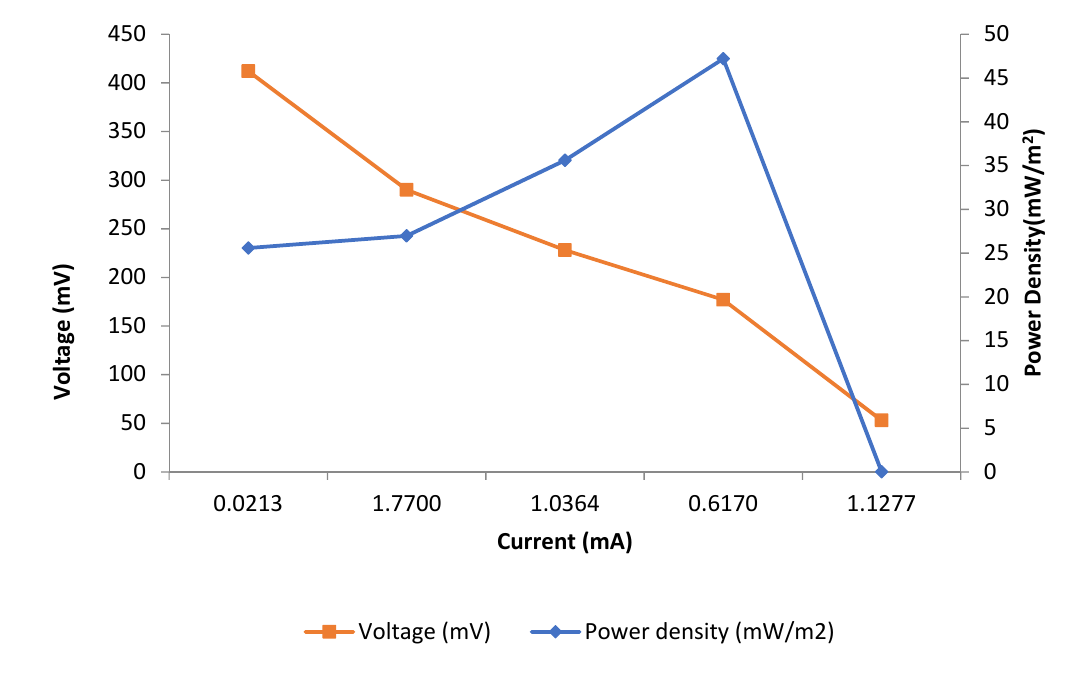
Figure 12. Polarization curve of ML-MFC.